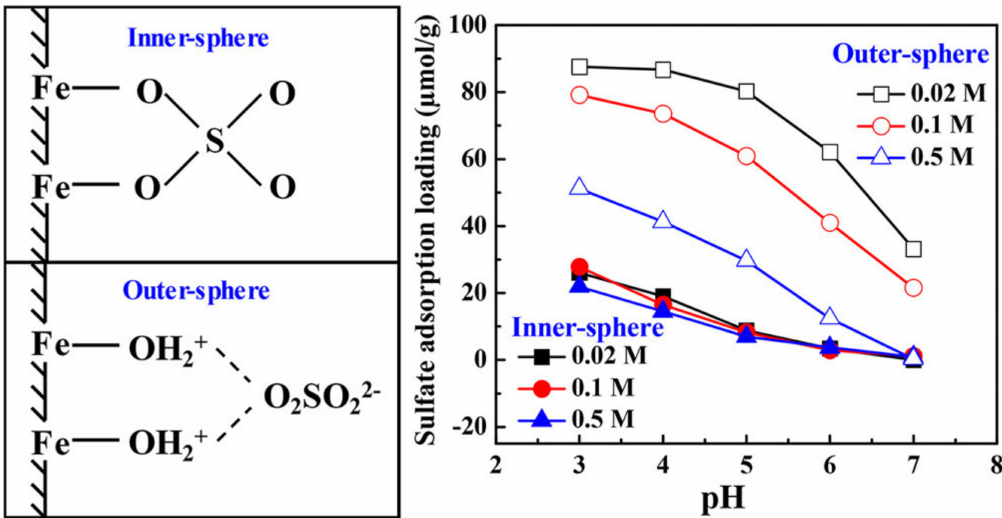
Figure 5. Illustration of mechanisms of SO 42 − adsorption on hematite ( left ). Amounts of SO 42 − adsorption on hematite ( µ mmol/g) at different pH ( right ). Changing ionic strength affects the amount of outer-sphere adsorbed SO 4 2 − at the different suspension pH values. At the highest ionic strength, the NO 3 − anions outcompete SO 42 − for the outer-sphere adsorption sites, but have minimal effect on the SO 42 − inner-sphere adsorption because NO 3- does not adsorb via inner- sphere complexation on hematite. Image adapted from Wang et al. [98] with